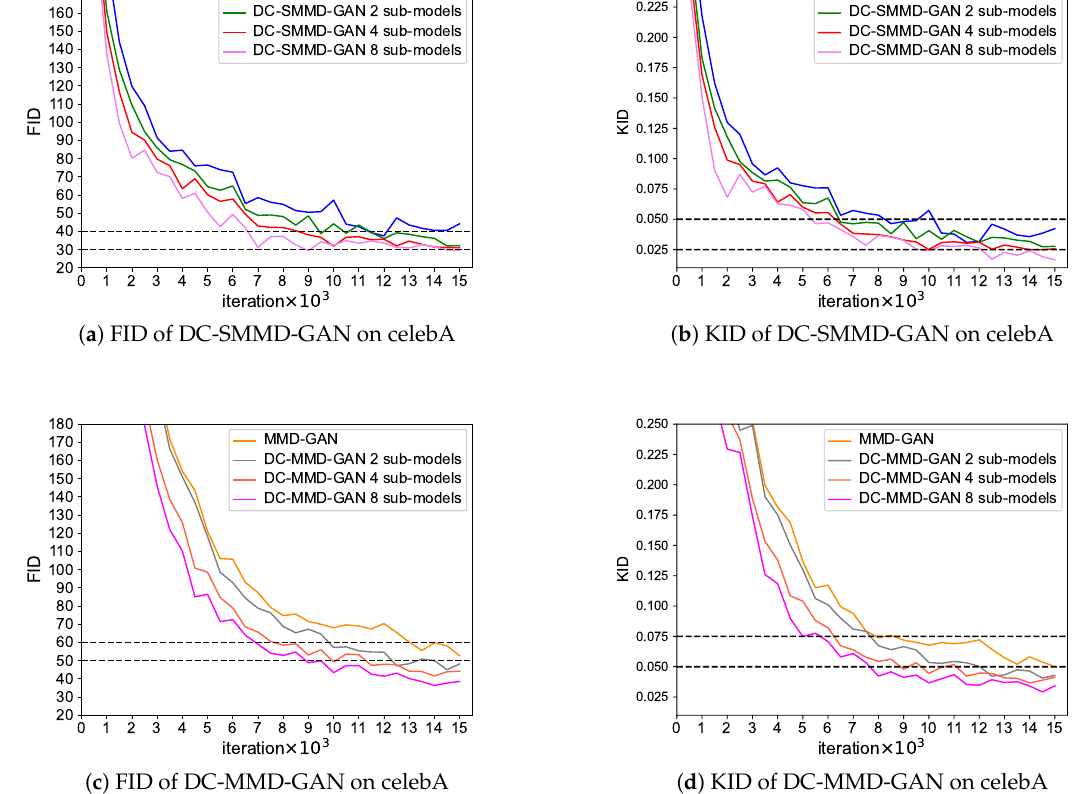
Figure 4. The evolution of FID and KID as the number of iterations increases when trained on celebA. Both on DC-SMMD-GAN and DC-MMD-GAN, the proposed methods can converge faster and obtain better evaluation score. Under the same number of iterations, the evaluation score becomes better as the number of sub-models increases. The improvement is obvious from the original models to the 4-sub-model methods. However, there is not obvious improvement when we add the number of sub-models to